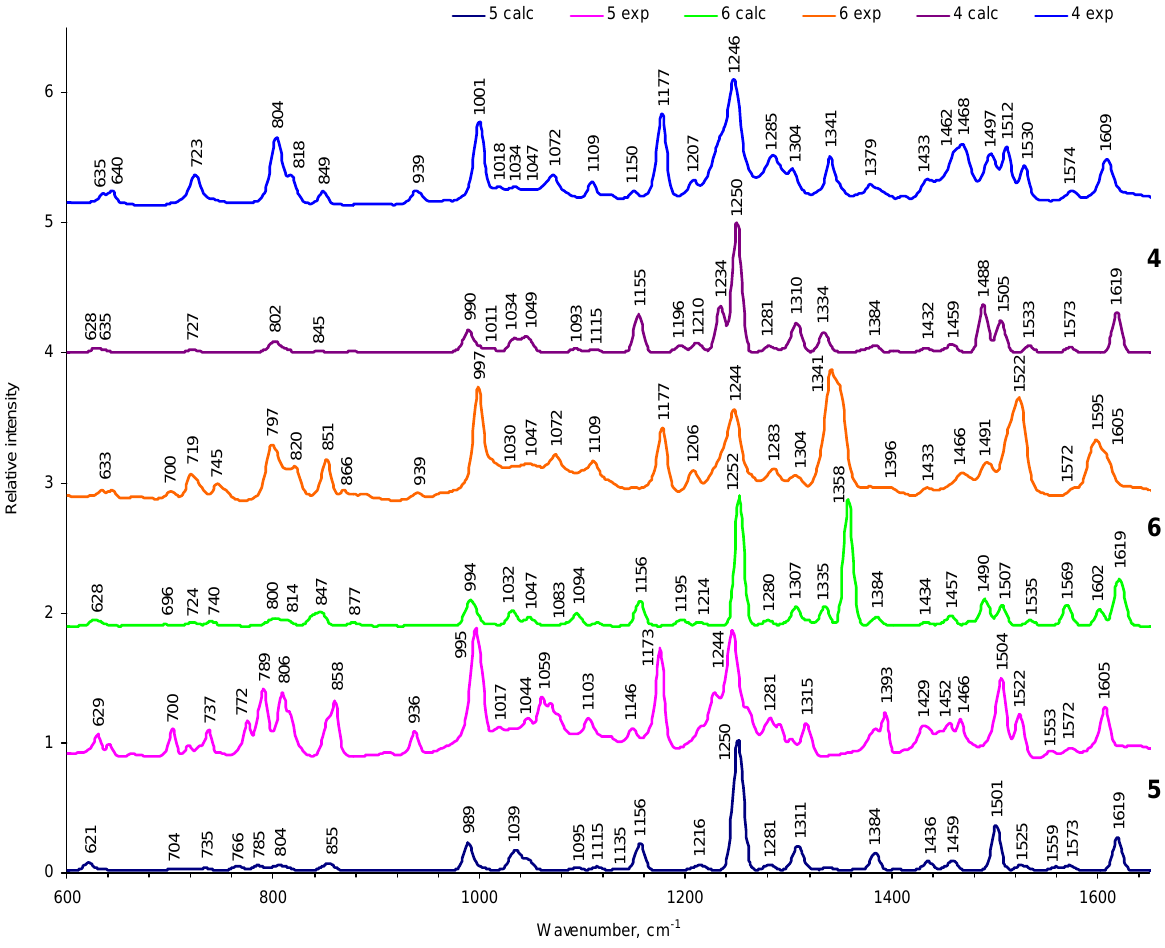
Figure 5. A comparison of the experimental and calculated IR spectra of investigated tetra-and di-phenyl porphyrins complexes with Zink ion (compounds 4–6